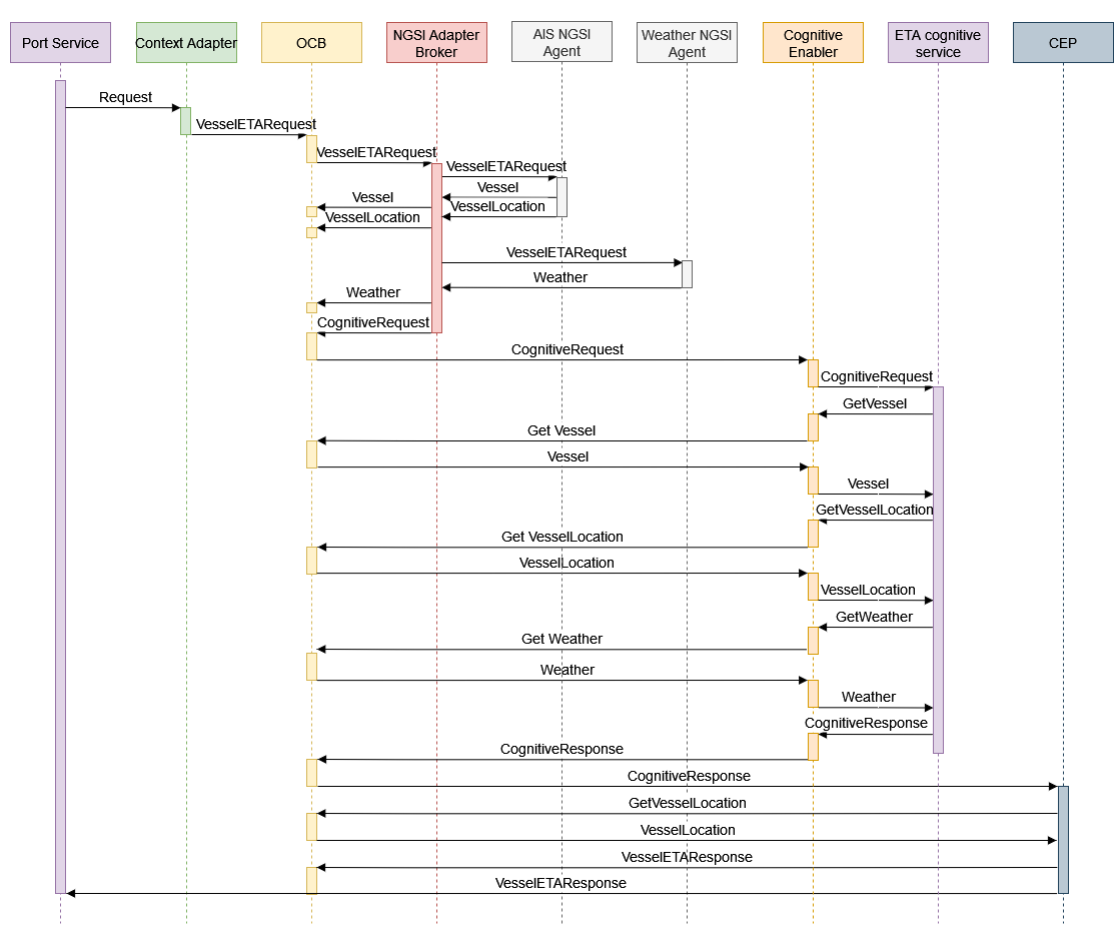
Figure 3. Message